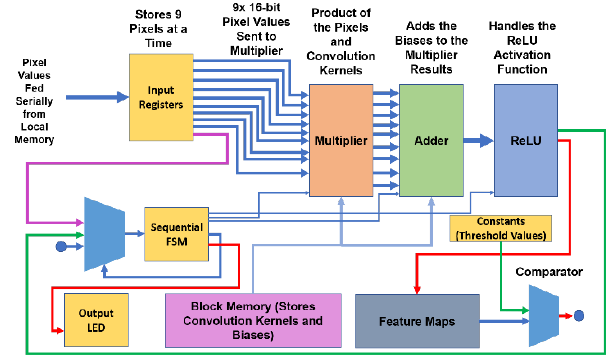
Figure 14. Overall system pipeline.